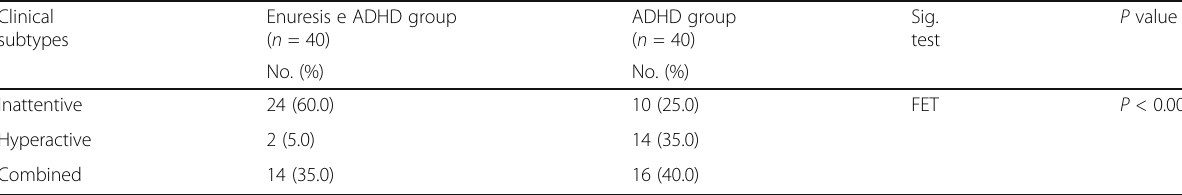
Table 2 Distribution of ADHD subtypes in relation to enuresis Clinical subtypes